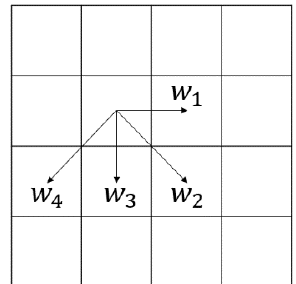
Figure 3. Propagation of errors to four different neighboring pixels with corresponding weighting coefficients in error diffusion